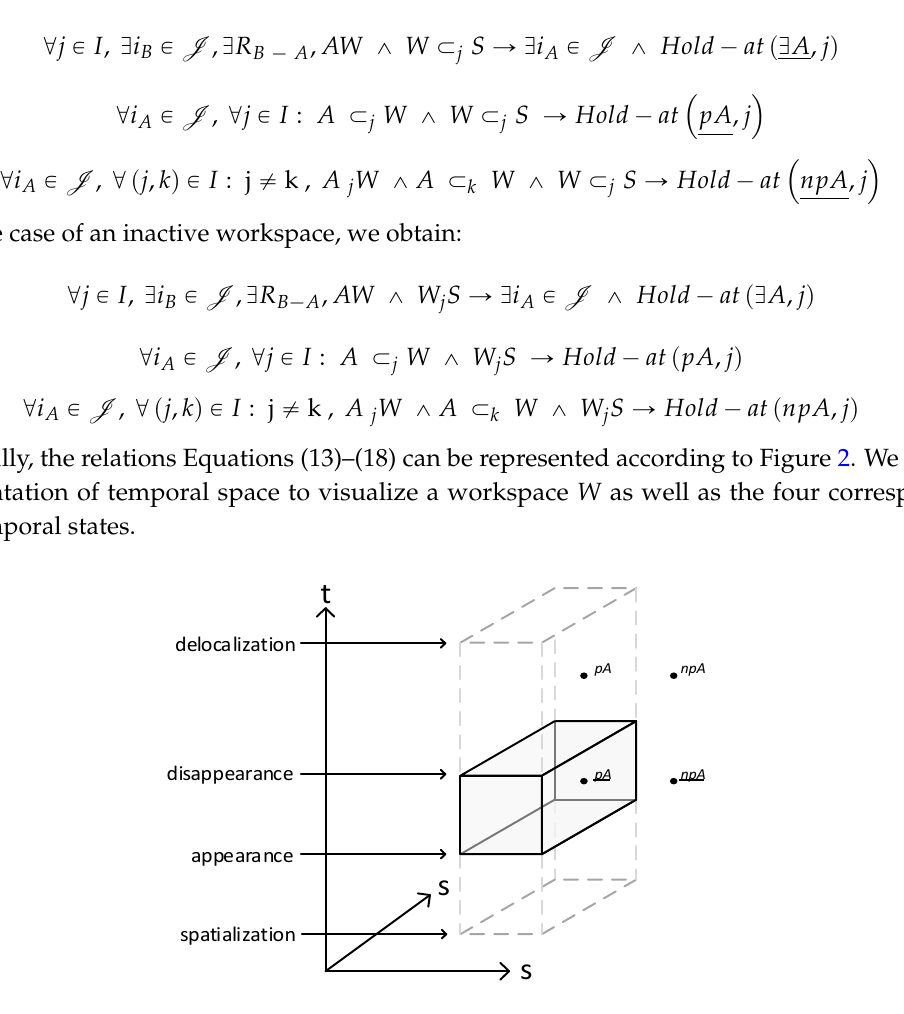
Figure 2. Representation in a temporal space of 4 spatio-temporal states applied to an active workspace (unbroken region) and inactive (dotted region). The transitions between states of activity in the workspace are described by the transition events.